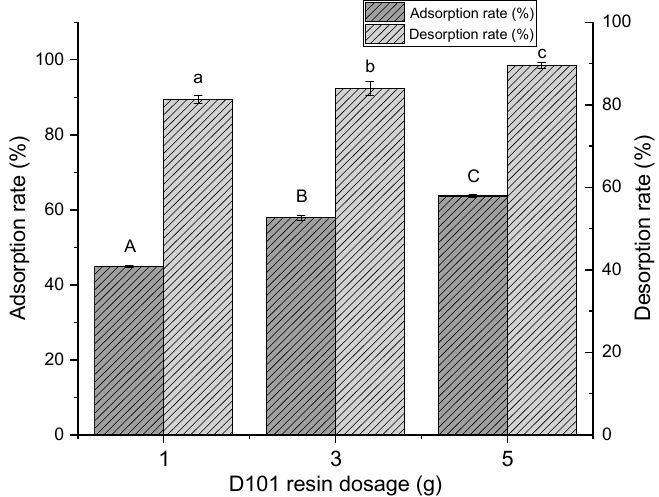
Figure 1. Adsorption and desorption rates of polyphenols from distiller’s grain with different amounts of added D101 resin (1, 3 and 5 g) under the condition of 30 ◦ C and 120 rpm for 24 h. Values with different letters (a–c and A–C) differ significantly ( P < 0.05) by Duncan’s multiple range test. Vertical bars represent the standard deviation for each value.